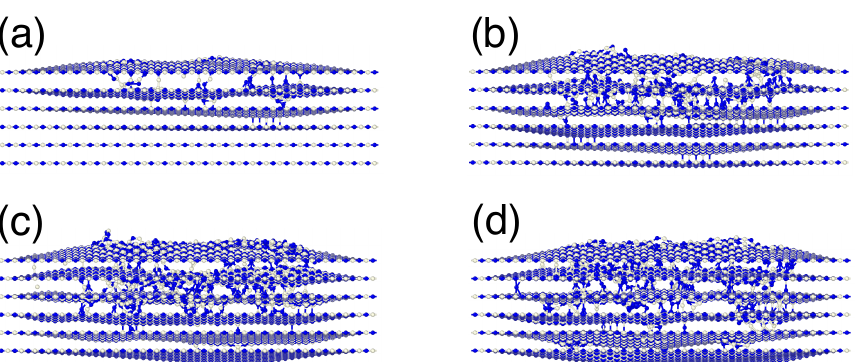
Figure 7. Typical atomic structures of multi-layer h-BN after irradiation with Ne ions with incident energies of 50 ( a ), 100 ( b ), 150 ( c ) and 200 ( d ) eV,